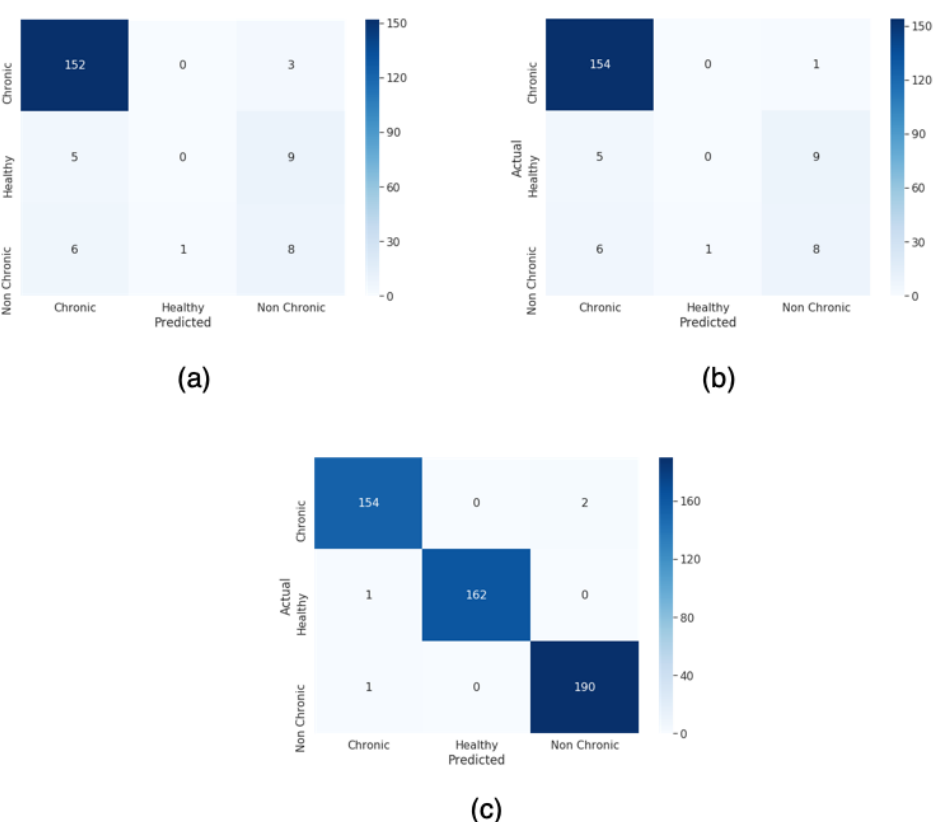
Figure 7. ( a ) Confusion matrix of the unbalanced dataset. ( b ) Confusion matrix of the unbalanced dataset with weights in the training. ( c ) Confusion matrix of balanced dataset using our proposal